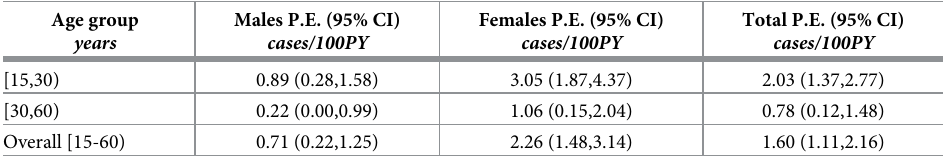
Table 1. Conventional biomarker-based estimates for large age